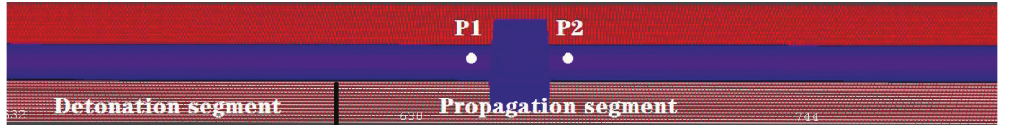
Figure 5: Geometric model and